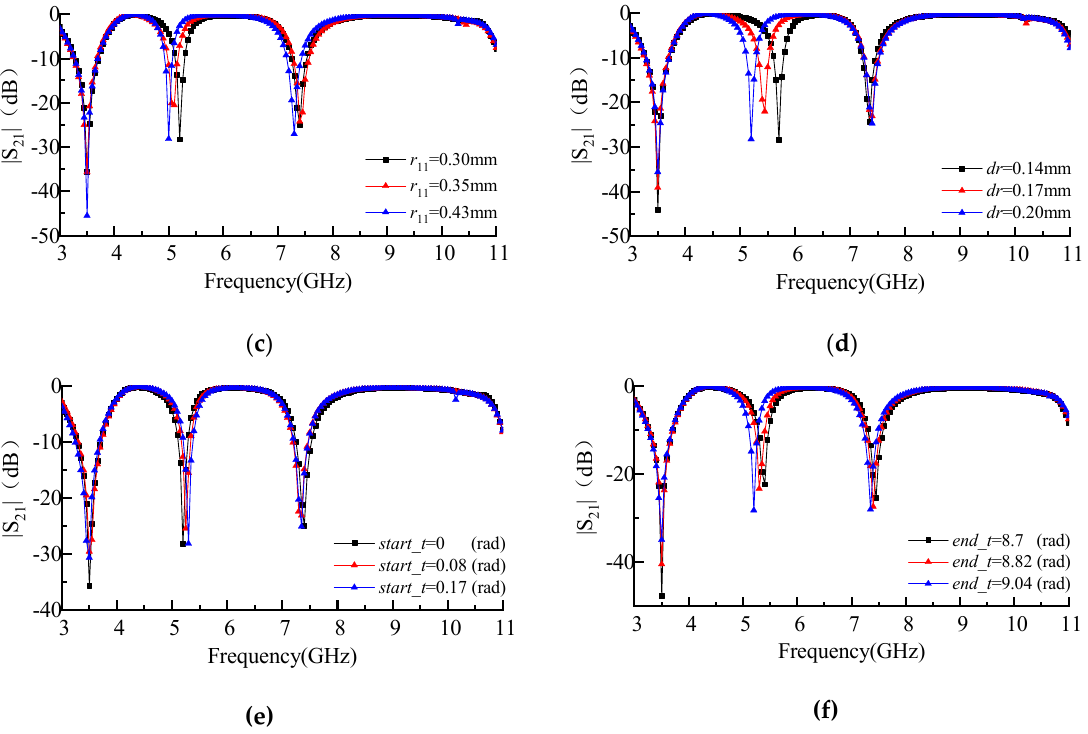
Figure 16. ( a ) Simulation results with different d ( d = 0.05 mm, f 2 = 4.9 GHz; d = 0.10 mm, f 2 = 5.2 GHz; d = 0.12 mm, f 2 = 5.25 GHz); ( b ) simulation results with different W 11 ( W 11 = 3.56 mm, f 2 = 5.75 GHz; W 11 = 3.68 mm, f 2 = 5.6 GHz; W 11 = 3.78 mm, f 2 = 5.5 GHz); ( c ) simulation results with different r 11 ( r 11 = 0.3 mm, f 2 = 5.2 GHz; r 11 = 0.35 mm, f 2 = 5.1 GHz; r 11 = 0.43 mm, f 2 = 5.0 GHz); ( d ) simulation results with different dr ( dr = 0.14 mm, f 2 = 5.7 GHz; dr = 0.17 mm, f 2 = 5.45 GHz; dr = 0.2 mm, f 2 = 5.2 GHz); ( e ) simulation results with different start_t ( start_t = 0 rad, f 2 = 5.2 GHz; start_t = 0.08 rad, f 2 = 5.25 GHz; start_t = 0.17 rad, f 2 = 5.3 GHz); ( f ) simulation results with different end_t ( end_t = 8.7 rad, f 2 = 5.4 GHz; end_t = 8.82 rad, f 2 = 5.3 GHz; end_t = 9.04 rad, f 2 = 5.2 GHz).